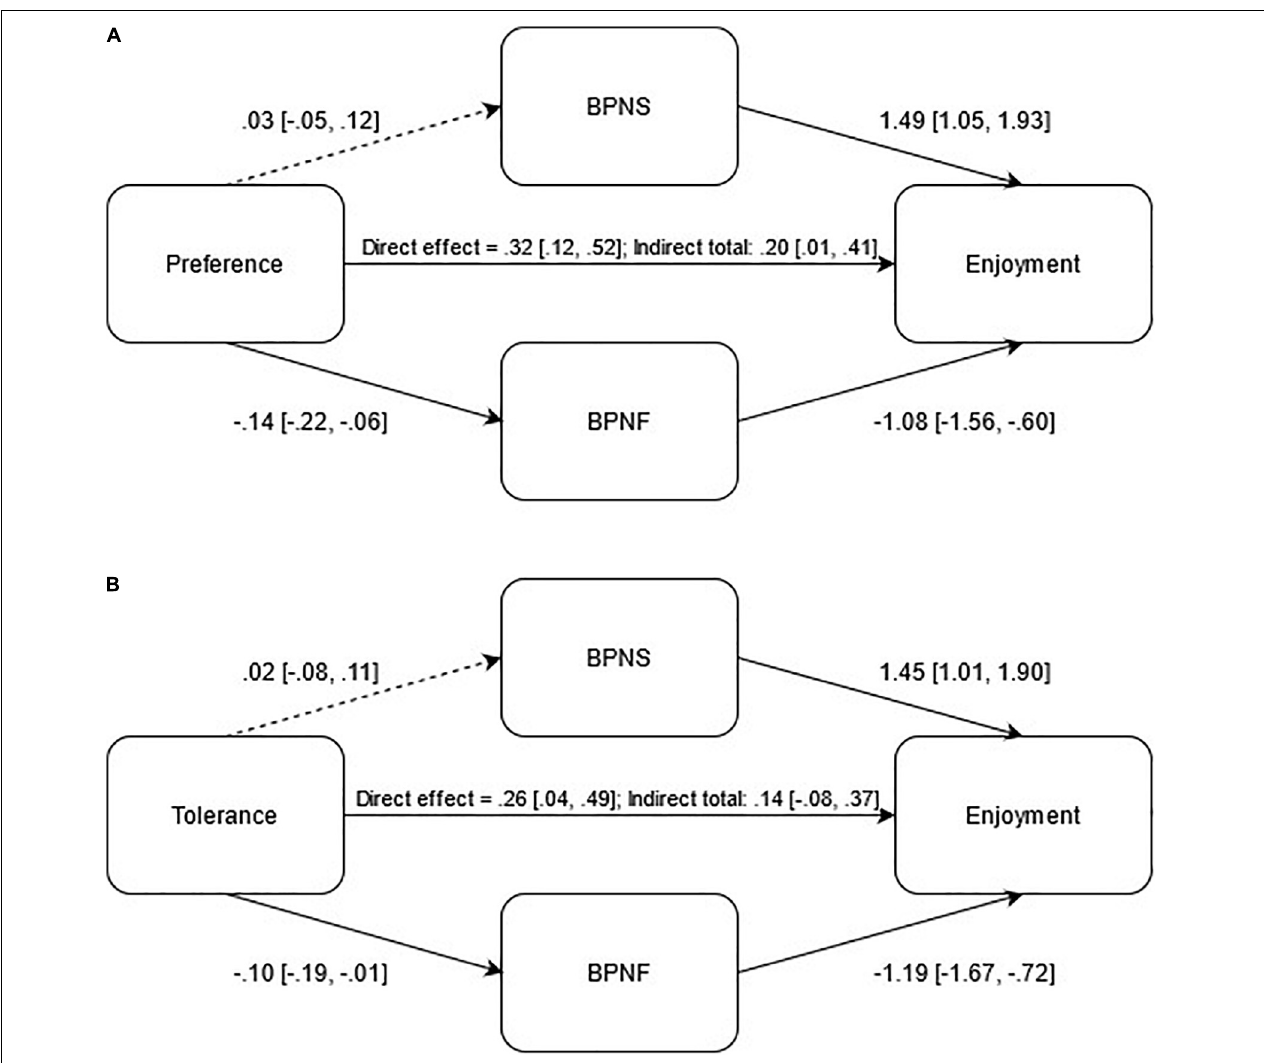
FIGURE 1 | Direct and indirect effects analysis of basic psychological needs satisfaction and frustration in the relationship between preference (A) and tolerance (B) on exercise enjoyment. Note . BPNS – Basic Psychological Needs Satisfaction; BPNF – Basic Psychological Needs Frustration; Dashed lines – nonsignificant